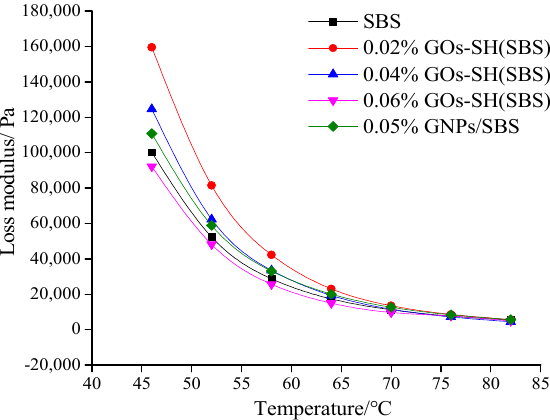
Figure 6. Variation in Tan δ (10 Hz) with temperature with variable GOs-SH content.